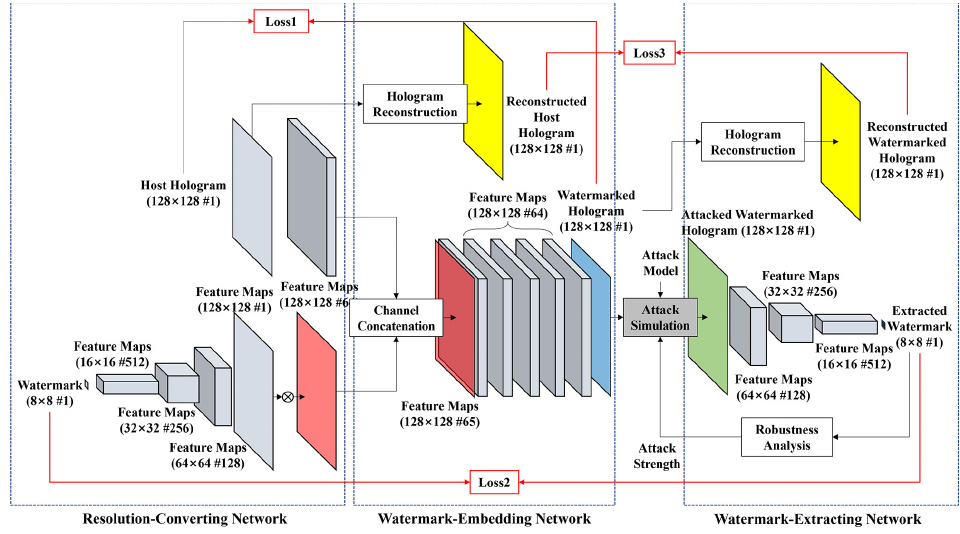
Figure 5. Training methodology of the deep neural network for